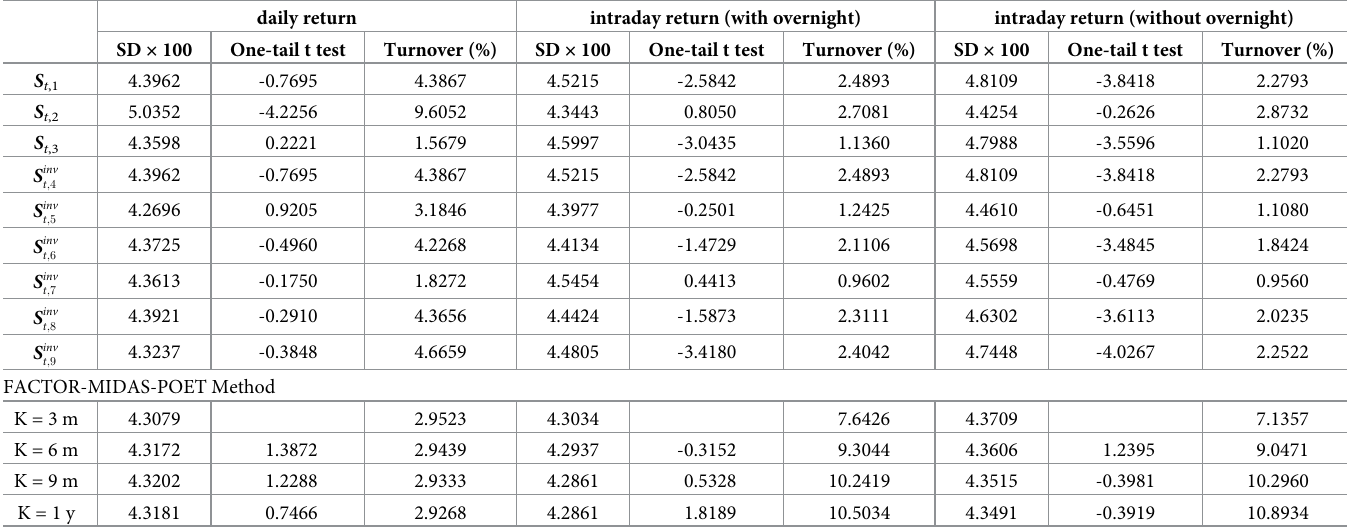
Table 8. Out-of-sample performances of portfolios with T = 9